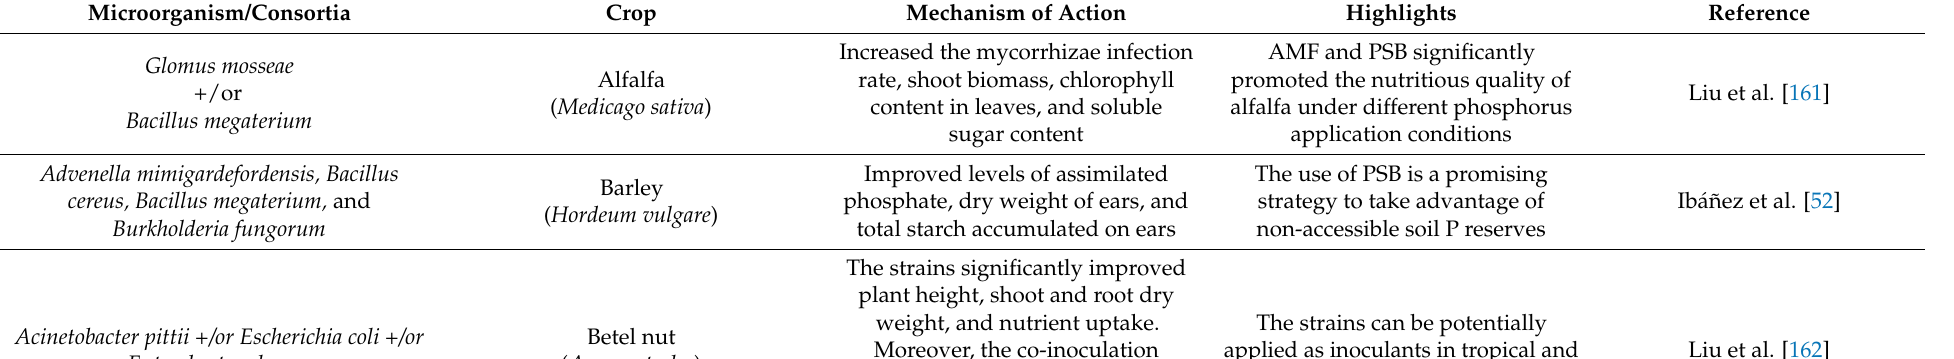
Table 1. Applications of growth-promoting microorganisms capable of phosphorus solubilization in